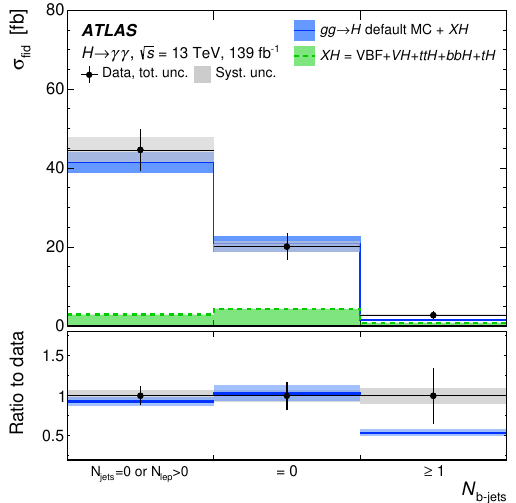
Figure 10. Particle-level fiducial differential cross-sections times branching ratio for the b -jet multiplicities variable N . The first bin includes events with no central jets or at least one lepton, b -jets while the two other bins contain events with zero or at least one b -jet in the remaining part of the diphoton fiducial phase space.